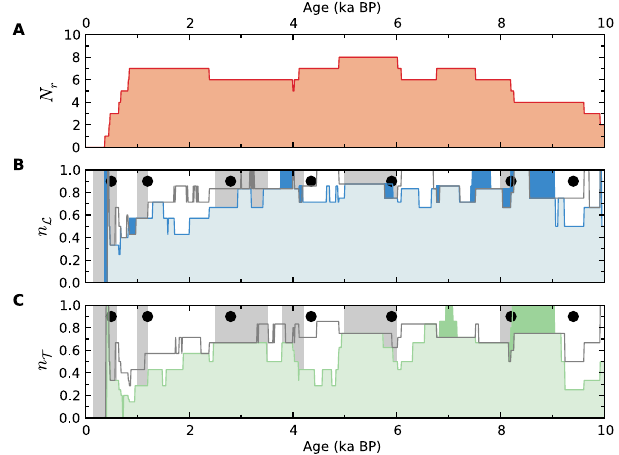
Figure 10. As in Fig. 9, but based on the COPRA ensembles of all considered palaeoclimate